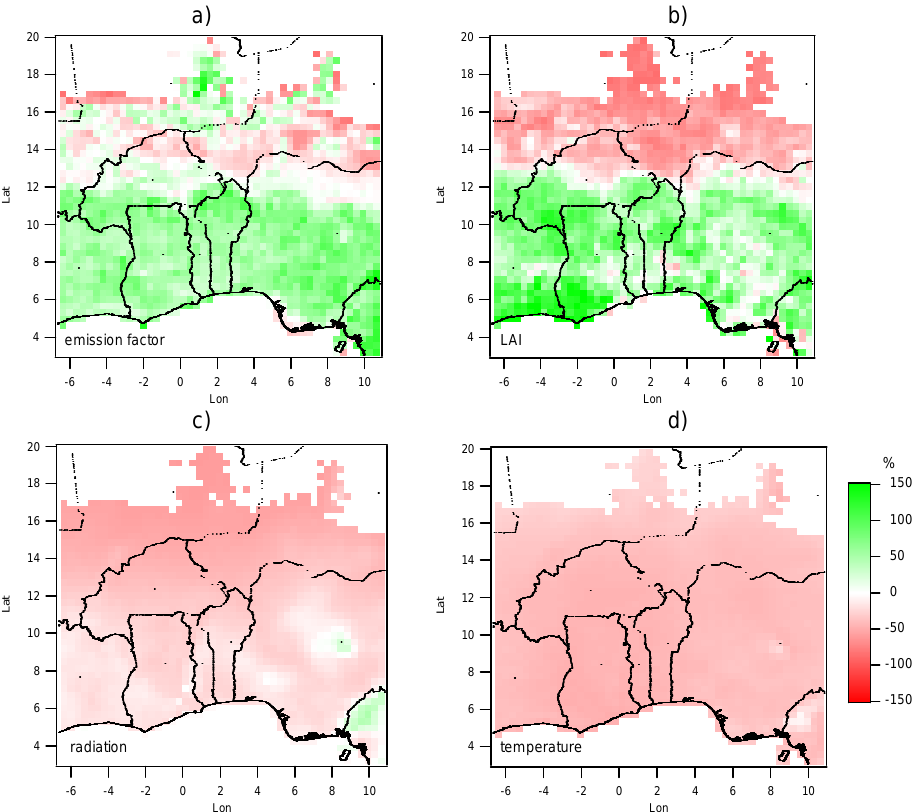
Fig. 5. Spatial distribution of the differentials in percentages obtained for August between each one of the four hypothetical runs performed with all but one variable constant and a run where all variables are constant in space and time, (e.g. plot a) refers to the differences in percentage between the run with all variables constant except emission factors and the run with all inputs constant). (a) emission factors, (b) LAI, (c) radiation and (d) temperature.